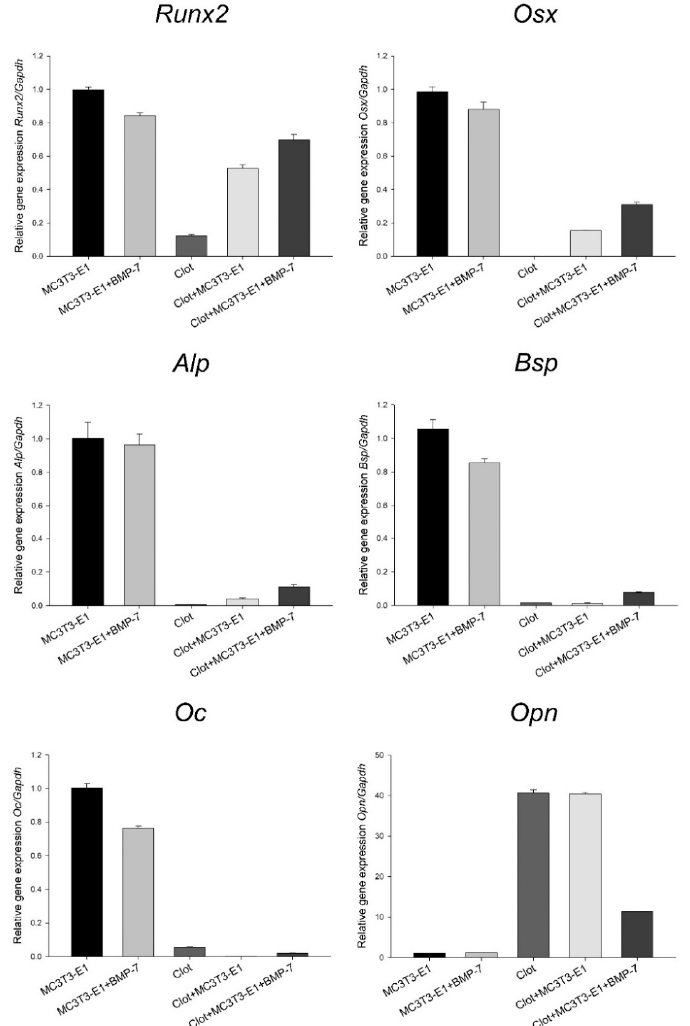
Figure 3. Runx2 , Osx , Alp , Bsp , Oc , and Opn mRNA expression levels normalized to Gapdh in MC3T3-E1 cell cultures grown for 5 days and in blood clots on time 0 on Nano-Ti surfaces either functionalized with or without rmBMP-7. The bars represent one biological replicate (resulting from the pooling of 16 independent wells/experimental replicates for each group) run in three technical replicates (mean and SD). The mean value of the control MC3T3-E1 group is assigned a value of 1. Additional technical replicates obtained in a different moment using the same cDNA result in a similar expression pa tt ern (Figure S5).